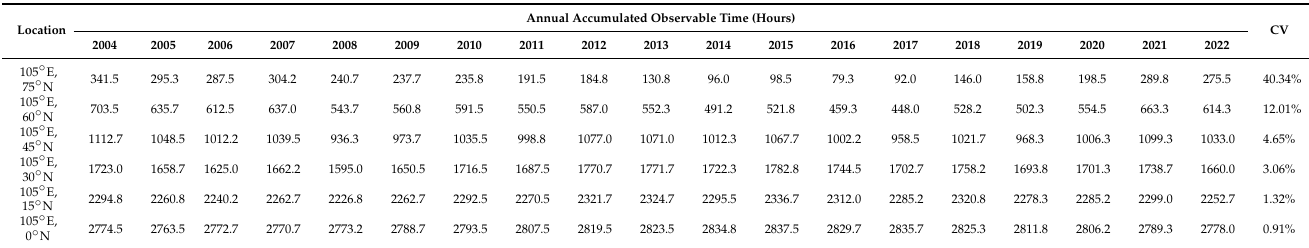
Table 1. Annual accumulated observable time of MS-BiSAR (GEO configuration) for different locations in one lunar precession